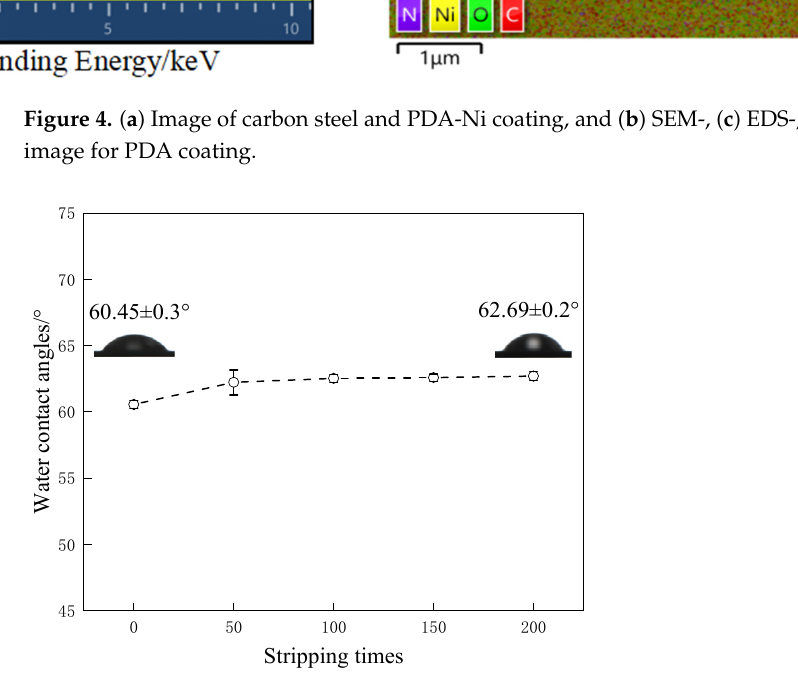
Figure 5. Evolution of water contact angle of PDA coating vs. stripping times.